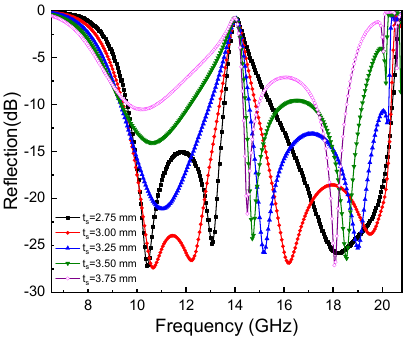
Figure 7. Reflection coefficients of co-polarization for various dielectric layer thicknesses.